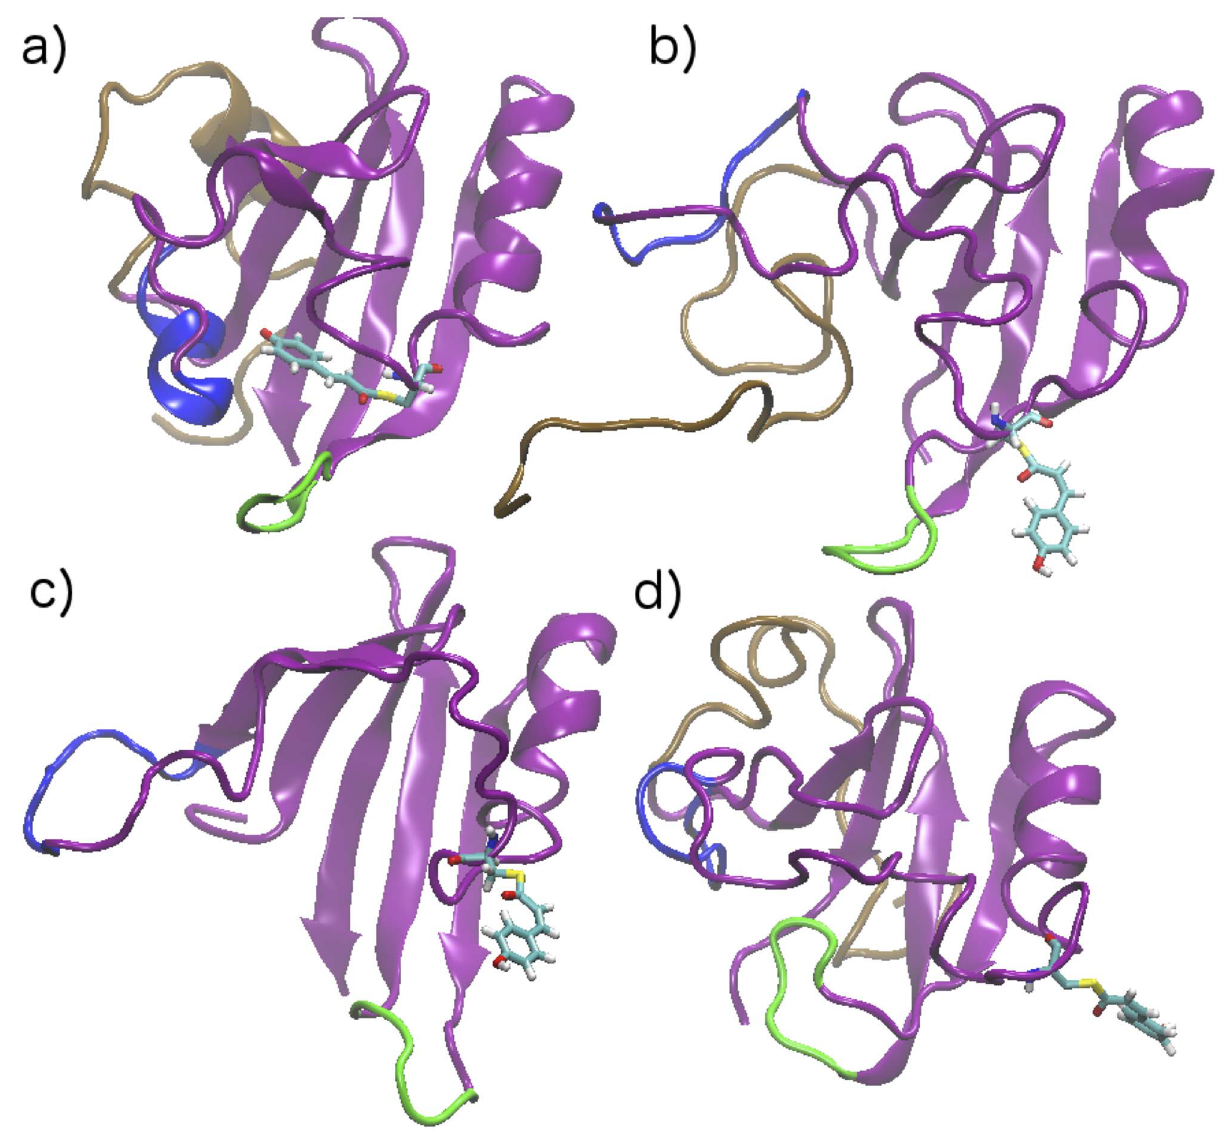
Figure 3. Configuration from a) pG state (PDB ID: 3PHY), b) experimental signaling state of WT-PYP (PDB ID: 2XK6), c) experimental signaling state of D 25 (PDB ID: 1XFQ), d) representative configuration from our pB ensemble. In all configurations the chromophore (residue 69) is shown explicitly, with the rest of the protein shown as cartoon. The a 3 helix (residues 43–51) is in blue, the chromophore binding cap (residues 98–103) in green, and the first 25 N-terminal residues, when present, in